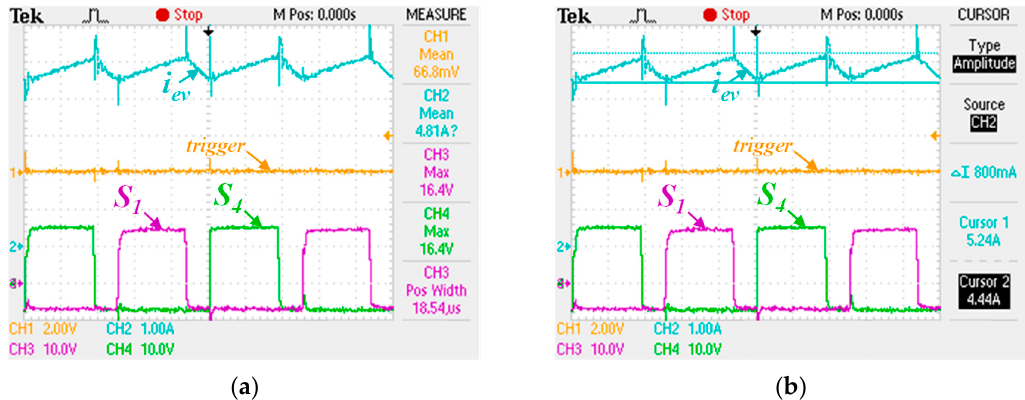
Figure 13. Steady-state operation of the multilevel dc–dc converter under normal conditions: ( a ) an i ev of 5 A and a duty cycle of 39% for semiconductors S 1 and S 4 ; ( b ) an i ev ripple value of 800 mA and a trigger value of 0